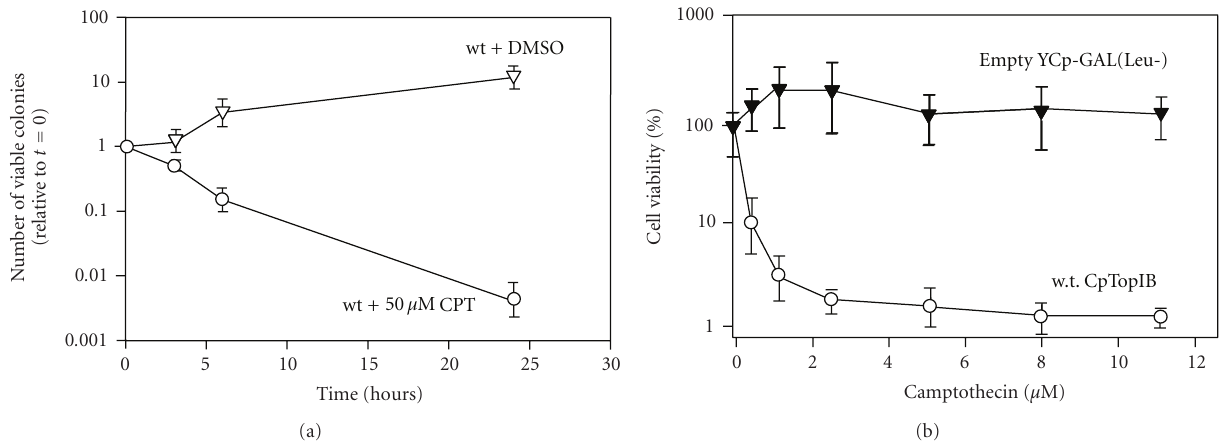
Figure 5: Yeast cell sensitivity to CPT depends on the expression of an active DNA topisomerase I from Cryptosporidium spp. (a) MBY3 yeast cells were transformed either with the YCp-GAL, vector empty, or carrying the wild type CpTopIB, in the presence or absence of 50 μ M CPT (dissolved into 1% DMSO) at t = 0. After 3, 6, 24, and 48 hours aliquots were serially diluted and plated in Petri dishes containing yeast culture medium plus 1% dextrose. (b) Dose-response curve showing the inhibitory e ff ect of CPT on yeast cell growing after 24 hours galactose induction. The number of colonies were determined at 30 ◦ C and plotted relative to the number of colonies obtained at t = 0. Data are the average of five di ff erent